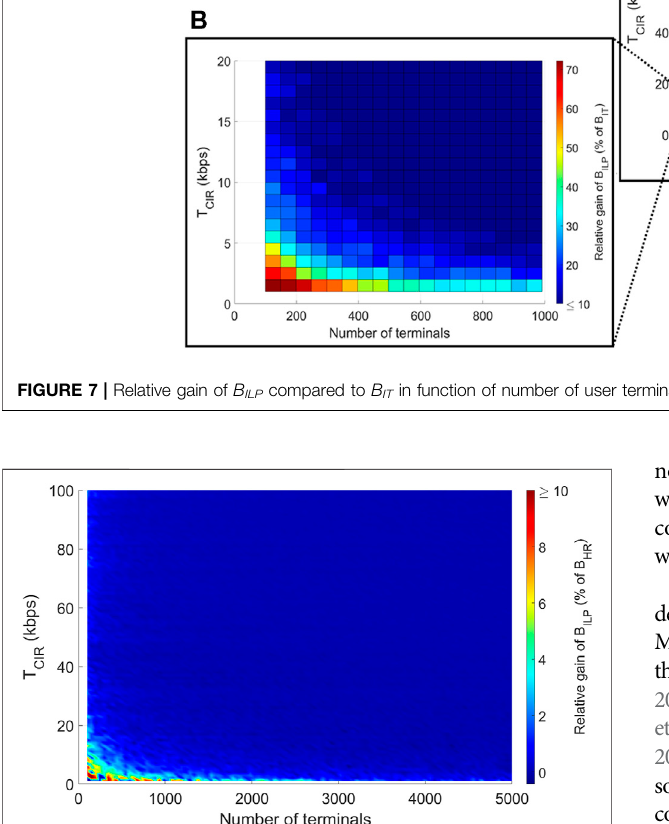
Frontiers in Communications and Networks |